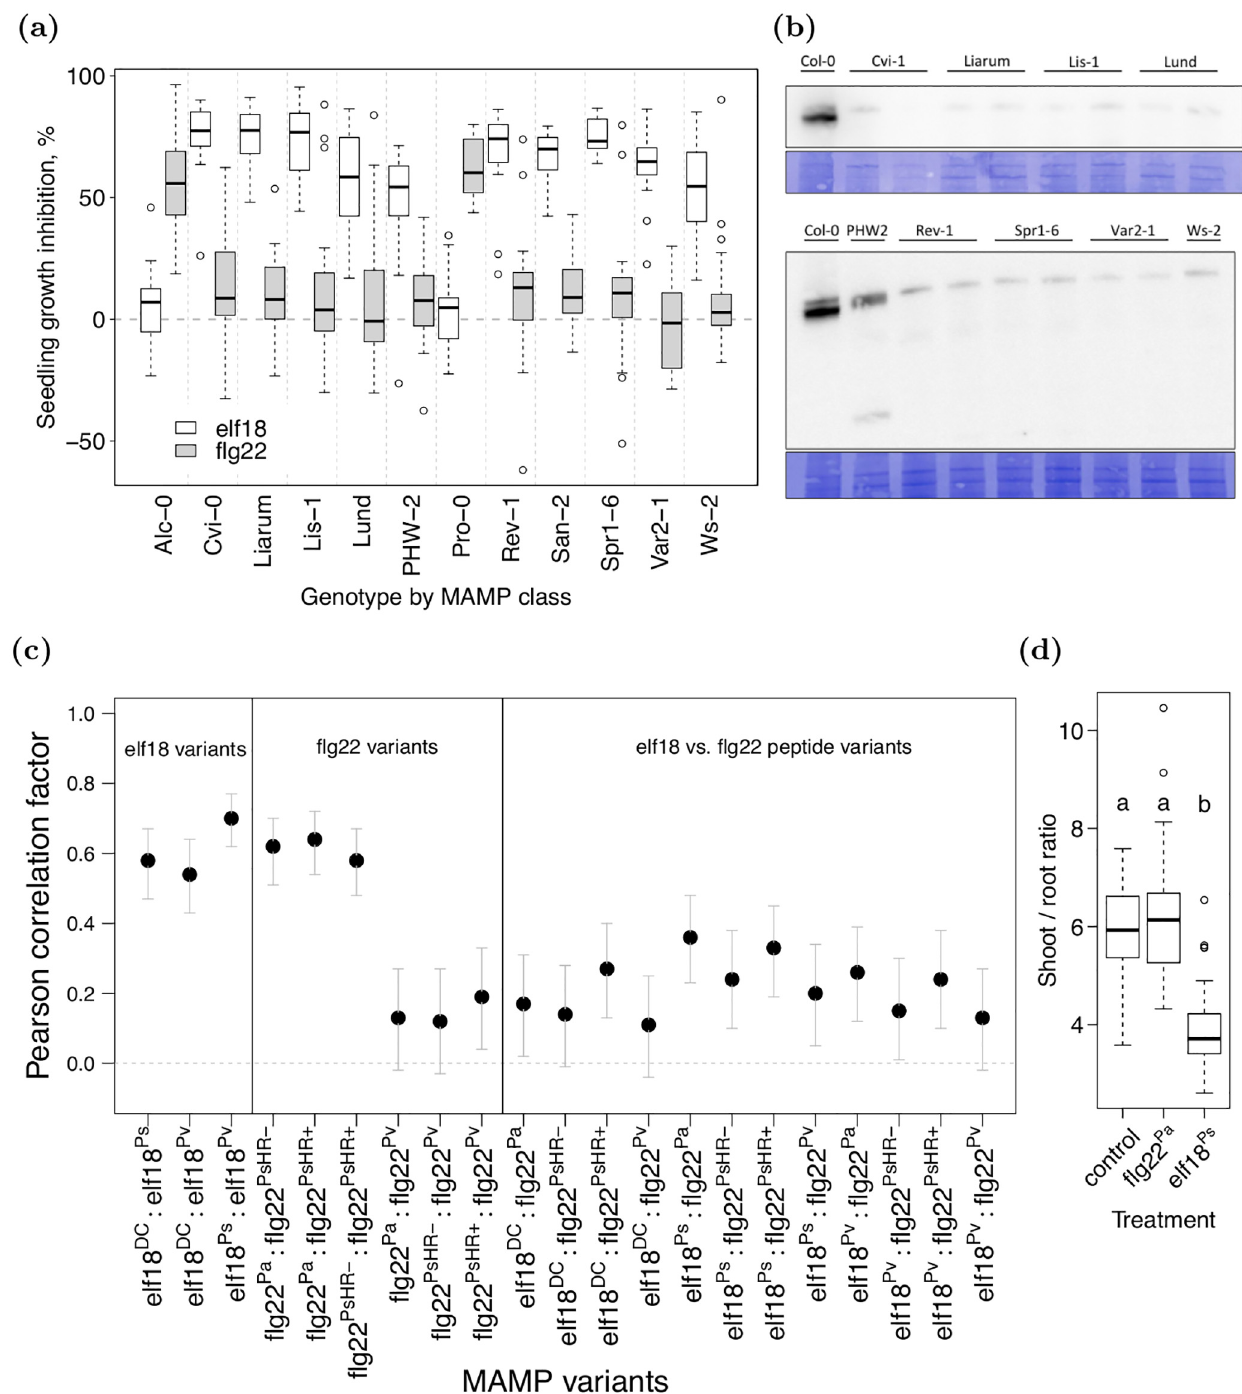
Fig 2. Different genetic basis of variation in the response to elf18 vs. flg22. (a) Genotypes that showed no SGI to one MAMP class are not impaired in their growth response to the other MAMP class. We classified genotypes as flg22-insensitive when they exhibited less than 15% SGI over all peptides in one MAMP class. The boxplots present SGI induced by the two MAMP classes (i.e., elf18 DC , elf18 Ps and elf18 Ps grouped as “ elf18 ” and flg22 Pa , flg22 PsHR + and flg22 PsHR − grouped as “ flg22 ” ). (b) Genotypes with low flg22-induced SGI exhibit reduced FLS2 protein abundance or a truncated FLS2 protein (PHW2). Two separate immunoblots and their corresponding coomassie colloidal blue stained membranes for total protein loading control. Immunoblots were conducted with an anti-FLS2 antibody that is directed against the kinase region of the flg22 receptor FLS2. We sequenced this region to ensure that the epitope recognized by the anti-FLS2 antibody is identical to the Col-0